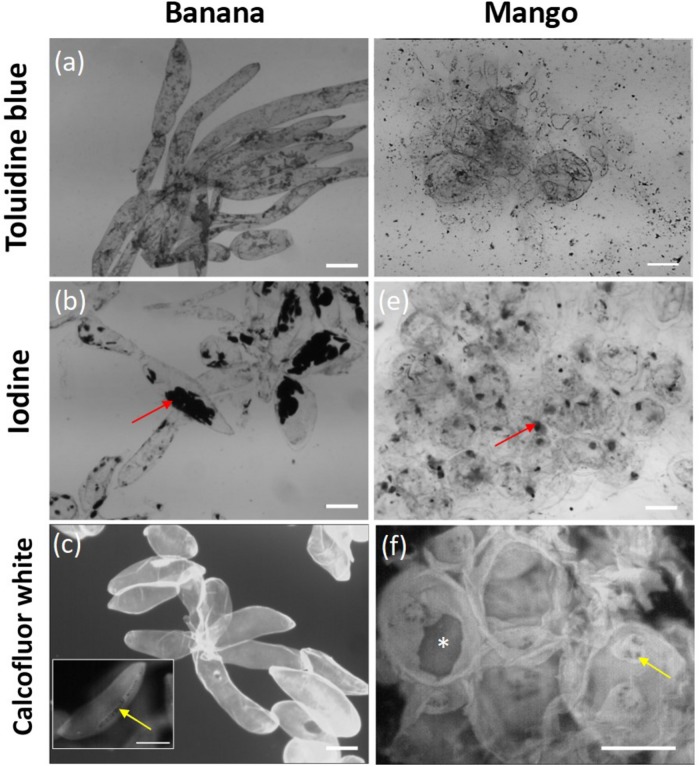
Micrographs of banana cells stained with toluidine blue (a), iodine (b) and calcofluor white (c); and mango cells stained with toluidine blue (d), iodine (e) and calcofluor white (f). Scale bar = 100 μm. Red arrows point to starch granules clearly visible in banana, yellow arrows point to the location of pit fields in strips in banana and round pits in mango. * Indicates tearing of the cell wall in mango fruit.